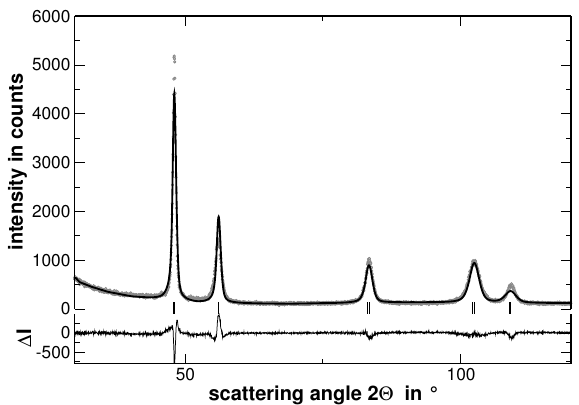
Figure A1. Experimental (points) and calculated (solid line) XRD patterns as well as their difference ∆ I (lower part) and Bragg positions (vertical lines) of homogenized